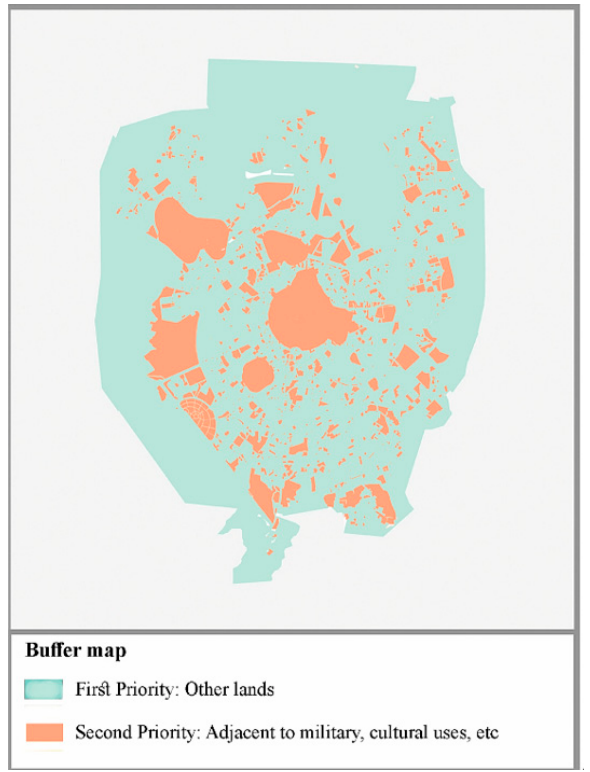
Figure 16. The buffer map of Hamedan based on the sub-criteria measures in Table 1.